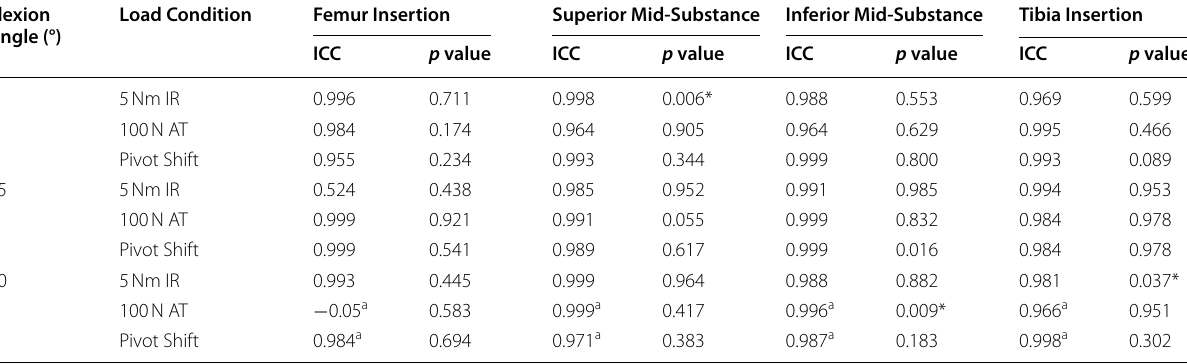
Table 2 ICC and p values calculated for trans-axial strains measured across five repeated trials at each load condition, for each region in the